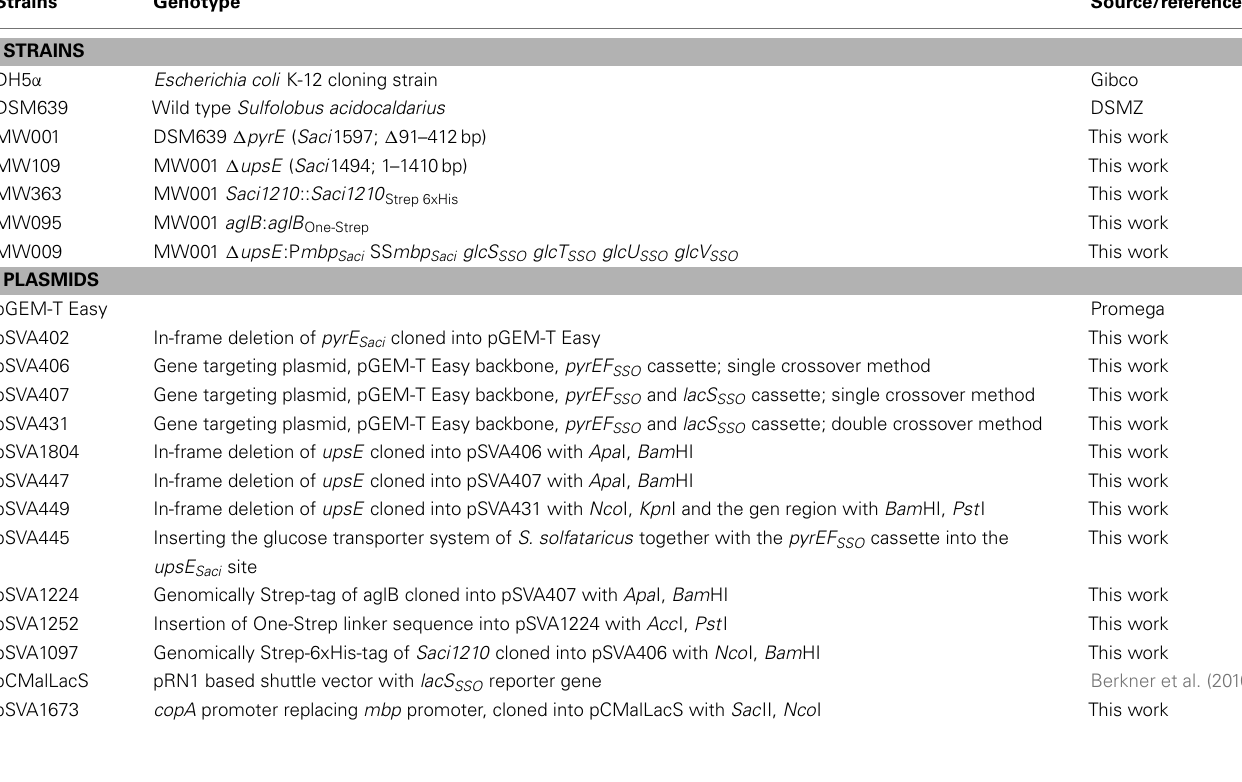
TableA2 | Strains and plasmids used in this study.